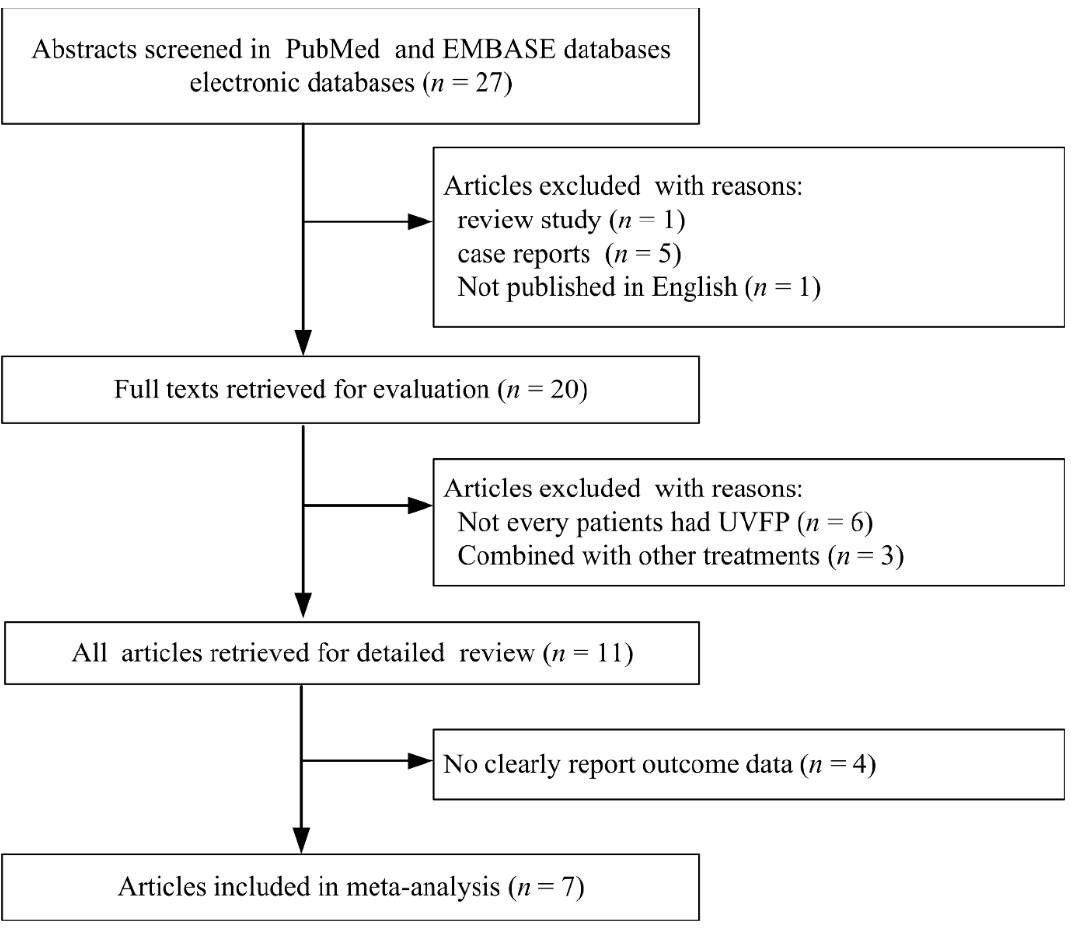
Figure 1. Flow diagram of this study.